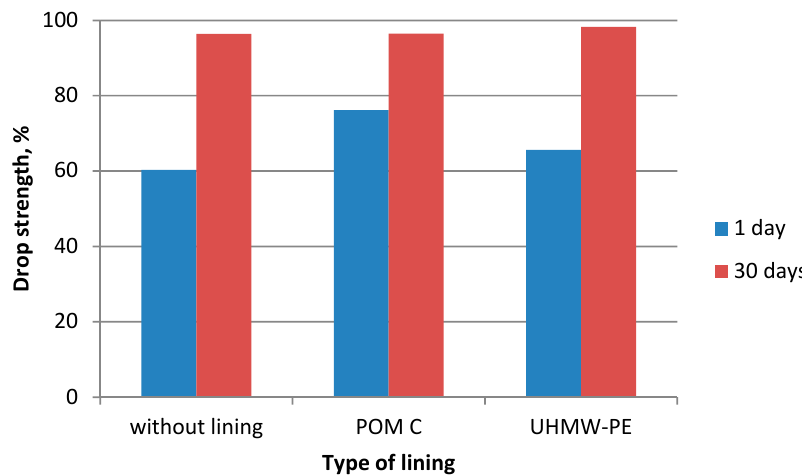
Figure 10. Drop strength of briquettes made of Mixture 3 (charcoal fines mixed with 4% of starch).